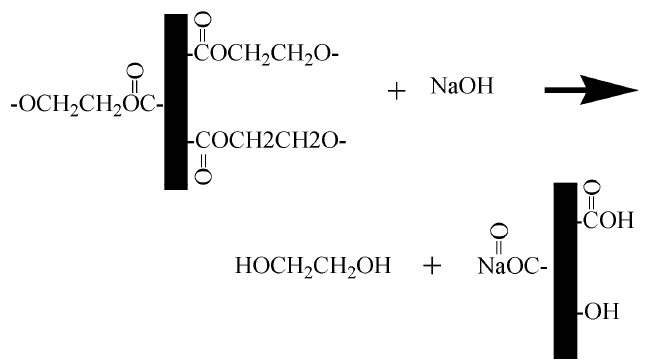
Figure 3. Hydrolysis of fiber with NaOH solution.